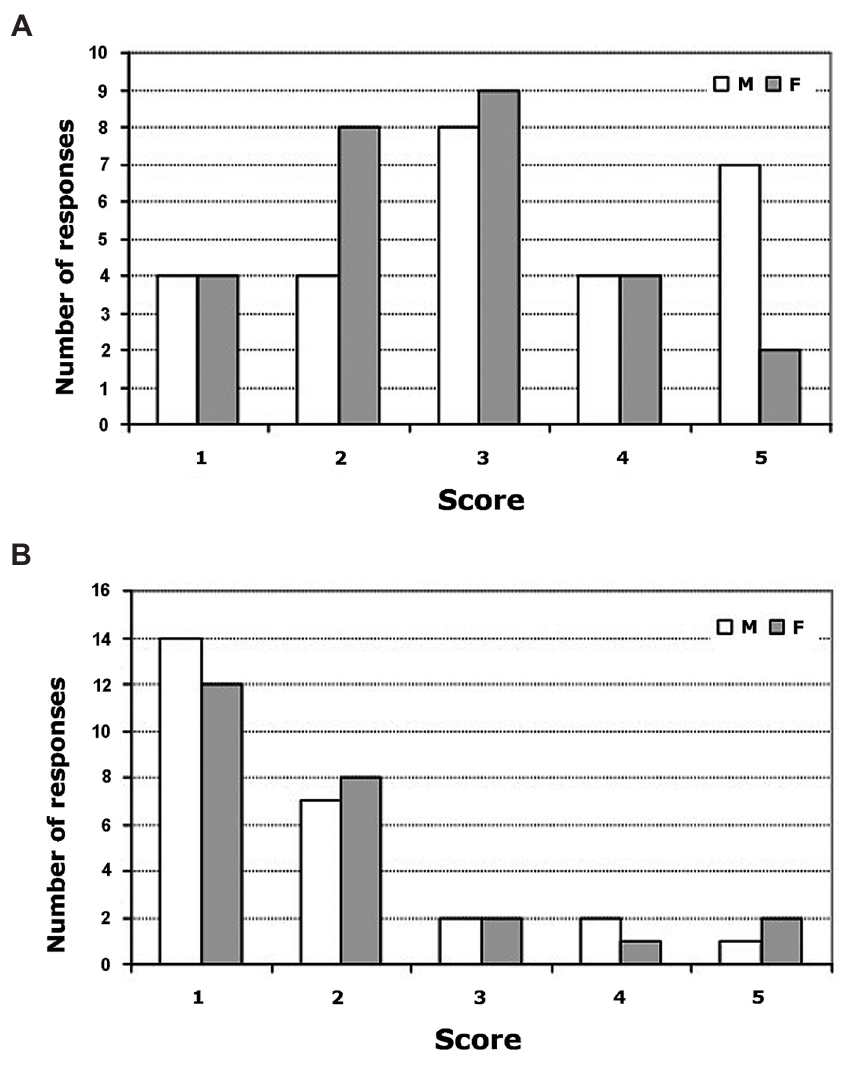
Figure 3 – Distribution of patient and partner responses on a 1-5 scale (ex.: 5 - very high, 4 - high, 3 - moderate, 2 - low, 1 - very low or not at all). M - male patients, F - female partners. Orgasm domain. A) Question 3: “Over the last 4 weeks, how satisfied are you with your ability to reach orgasm during sexual activity or intercourse after prostate cancer treatment?”. B) Question 4: “Over the last 4 weeks. How satisfied are you with your partner’s ability to reach orgasm during sexual activity or